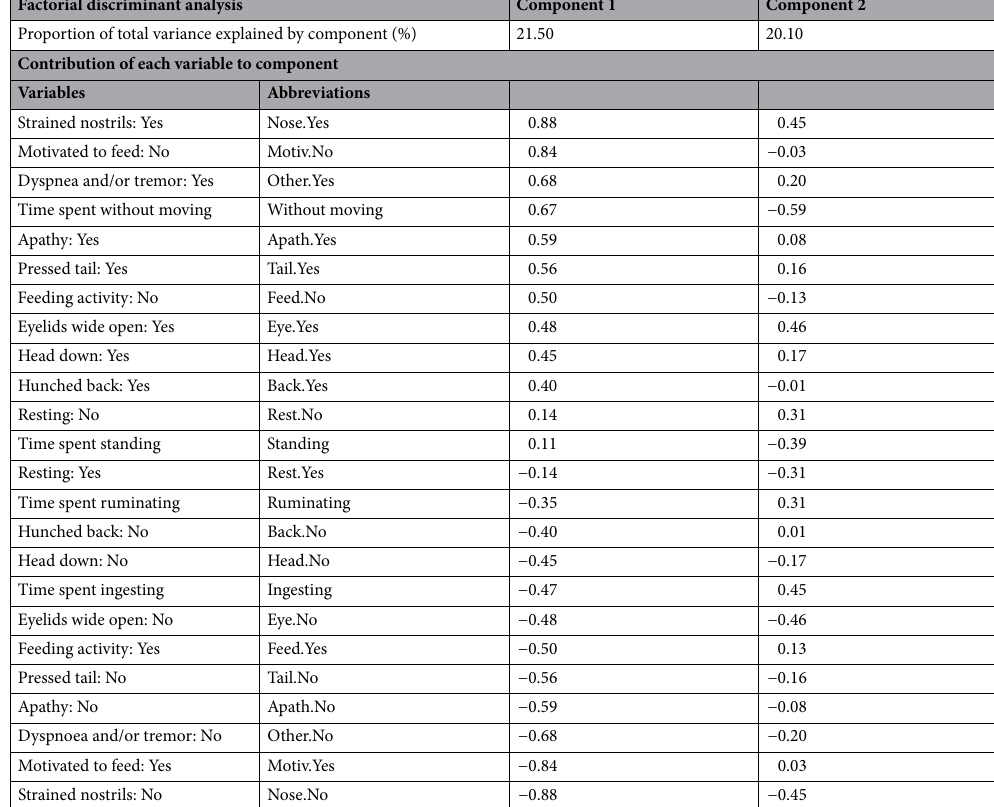
Table 4. Factorial discriminant analysis on behavioural signs in 6 old and 6 young Holstein cows under LPS CHALLENGE and CONTROL situations at T−1 h, T + 3 h, T + 6 h, T + 12 h and T + 24 h after intravenous injection of LPS (0.5 µg/kg of BW) (or equivalent time in the CONTROL situation): proportion of variance explained by each component, and variable-to-component